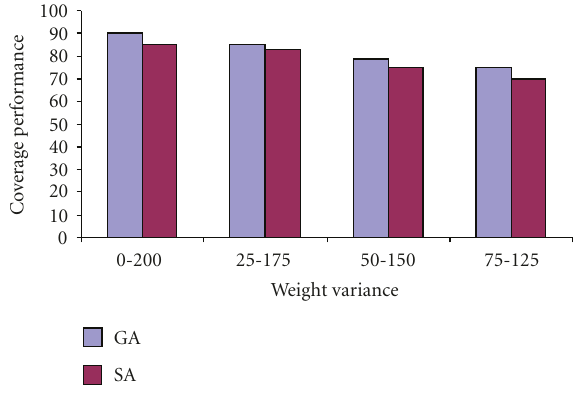
Figure 14: E ff ect of zones’ weight variance on the coverage perfor- mance of GA and